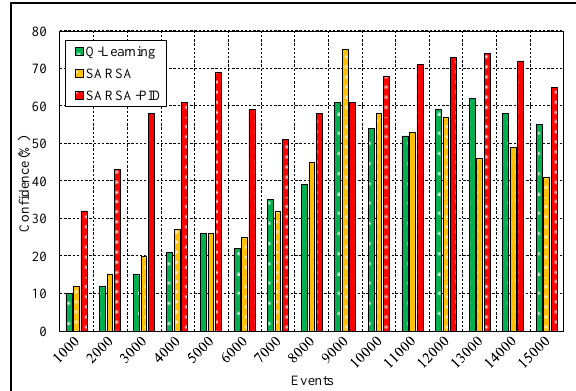
Figure. 5. The Confidence